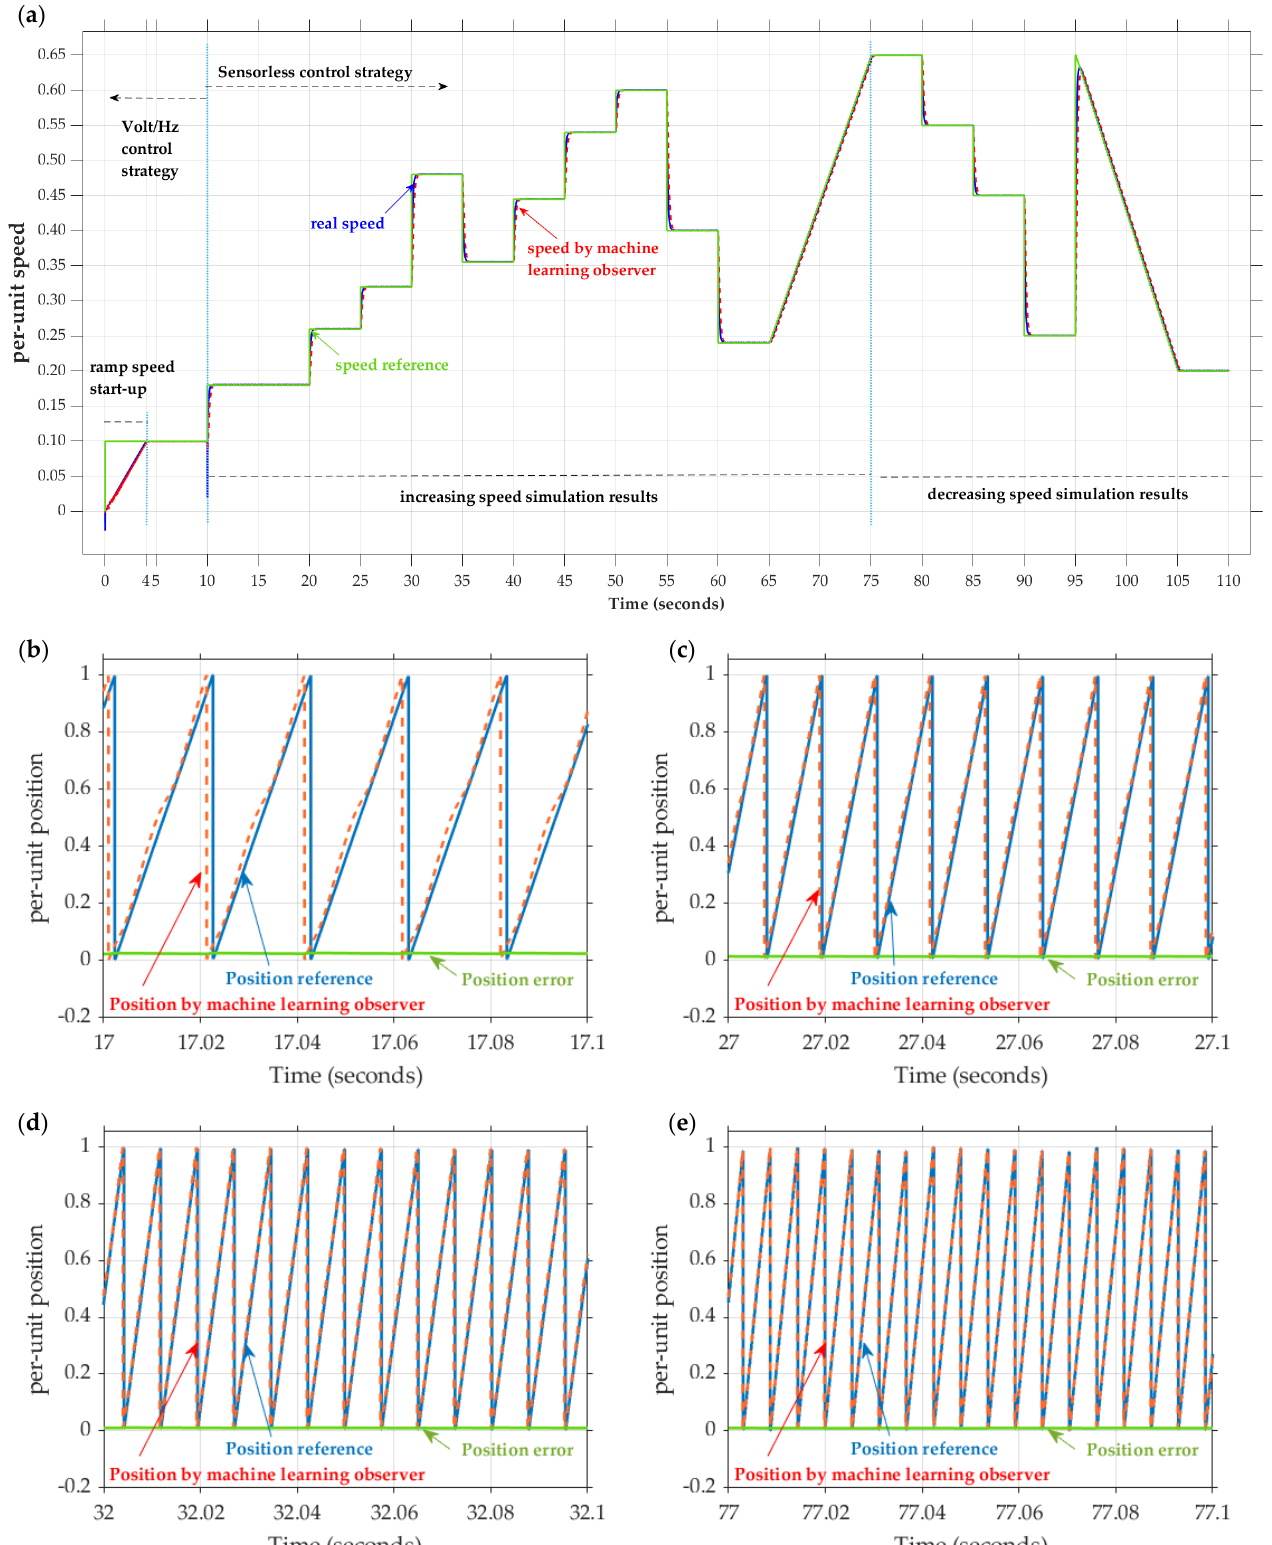
Figure 12. Simulation results for ( a ) rotor speed responses and for rotor positions at ( b ) 0.18, ( c ) 0.32, ( d ) 0.48, and ( e ) 0.65 p.u-speed.